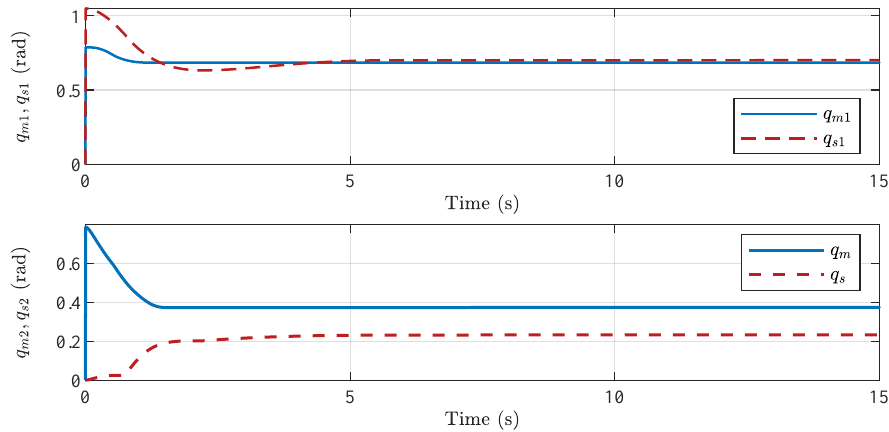
Figure 16. Joint positions of the master and slave end-effectors with the method in Case